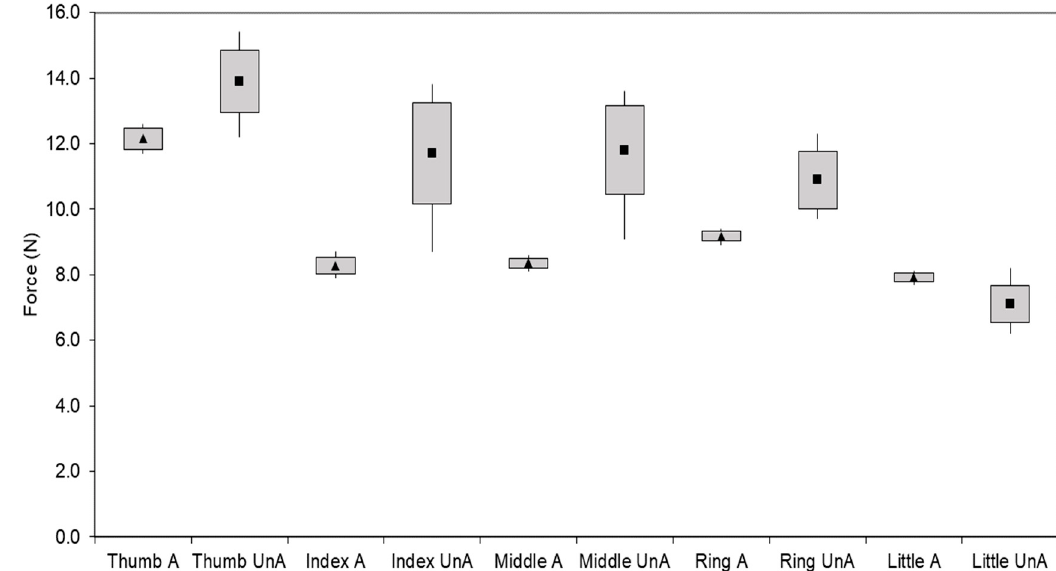
Figure 12. Finger force measured normal to fingertip.